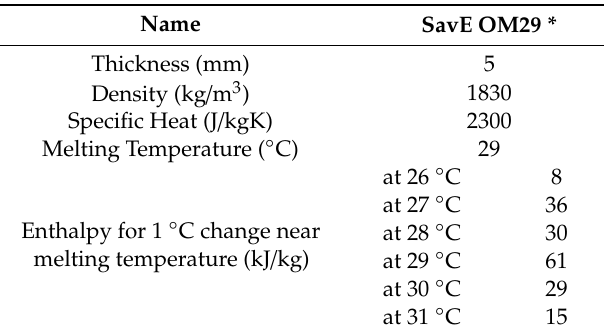
Table 3. Material properties of PCM.